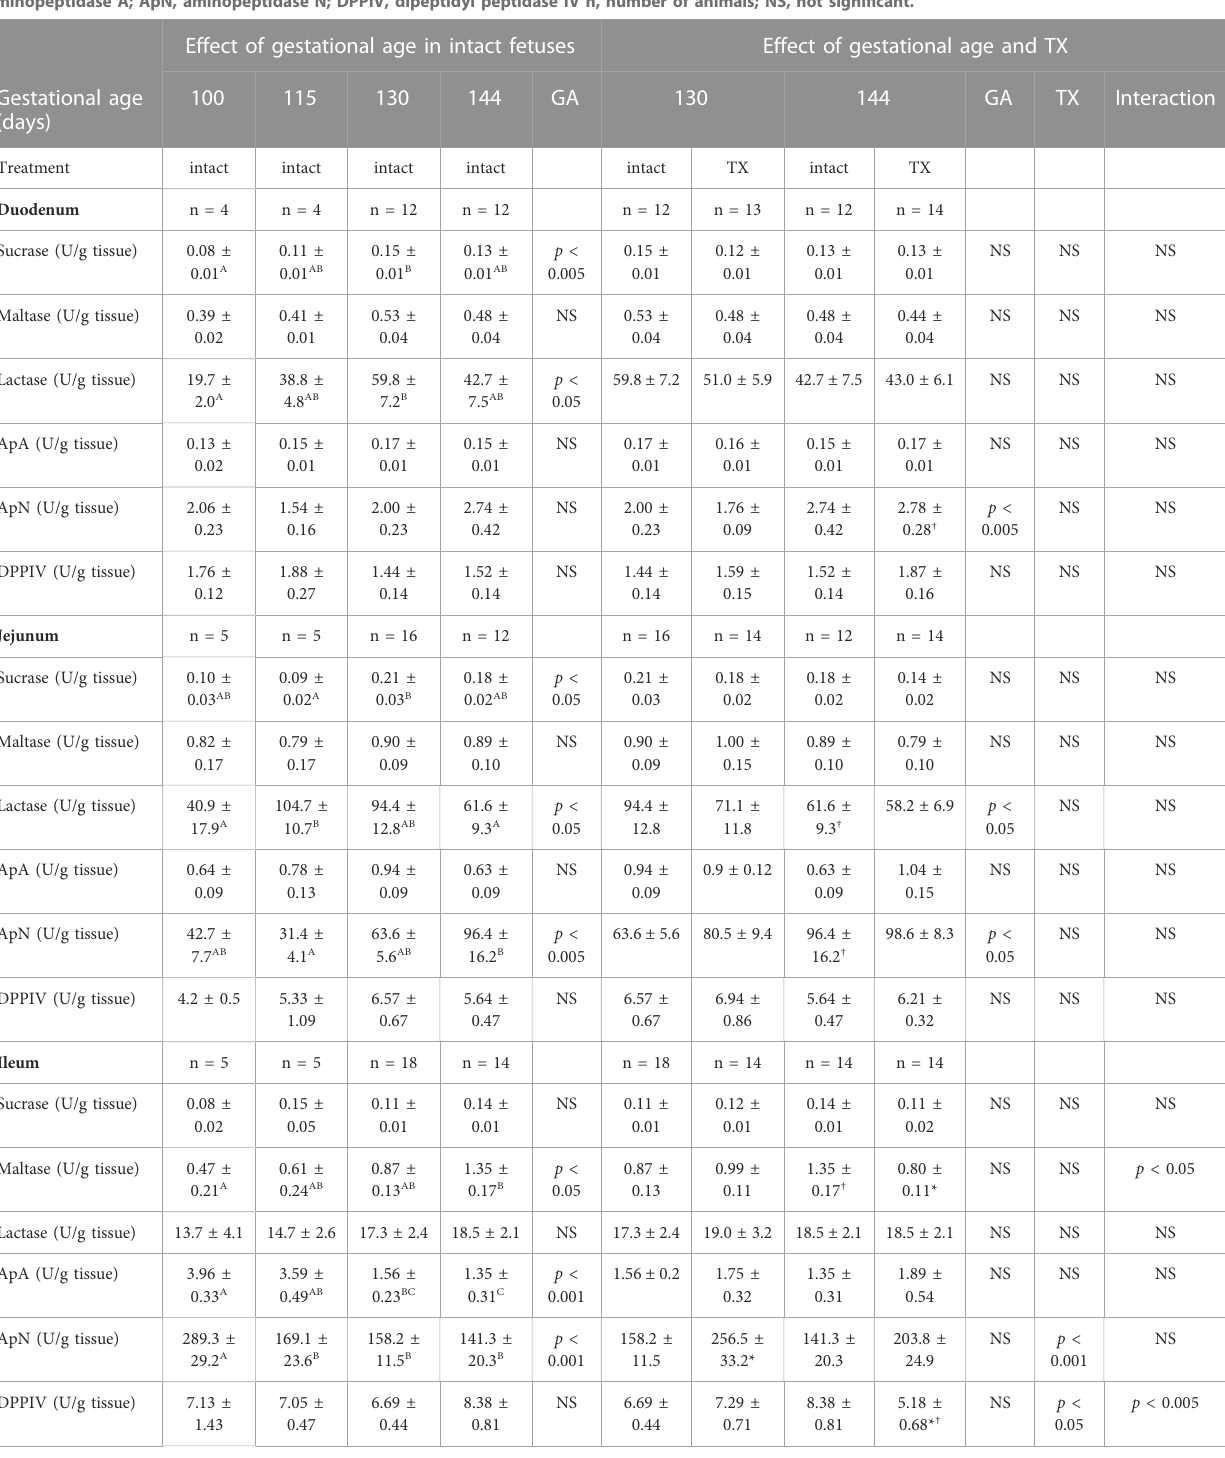
TABLE 2 Mean (±SEM) activities of intestinal enzymes in the fetuses of each experimental group at tissue collection. One-way ANOVA assessed the effect of gestational age in the intact fetuses between 100 and 144 days of gestation: for each parameter measured, values with different superscript letters are signi fi cantlydifferentfromeachother( p < 0.05,Tukey ’ s posthoc test).Two-way-ANOVAexaminedtheeffectsofgestationalageandTXintheintactandTXfetuses studied at 130 and 144 days of gestation: *, signi fi cant difference from intact fetuses at the same gestational age ( p < 0.05, Tukey ’ s post hoc test); † , signi fi cant difference from fetuses of the same treatment at 130 days of gestation ( p < 0.05, Tukey ’ s post hoc test). GA, gestational age; TX, thyroidectomy; ApA, aminopeptidase A; ApN, aminopeptidase N; DPPIV, dipeptidyl peptidase IV n, number of animals; NS, not signi fi